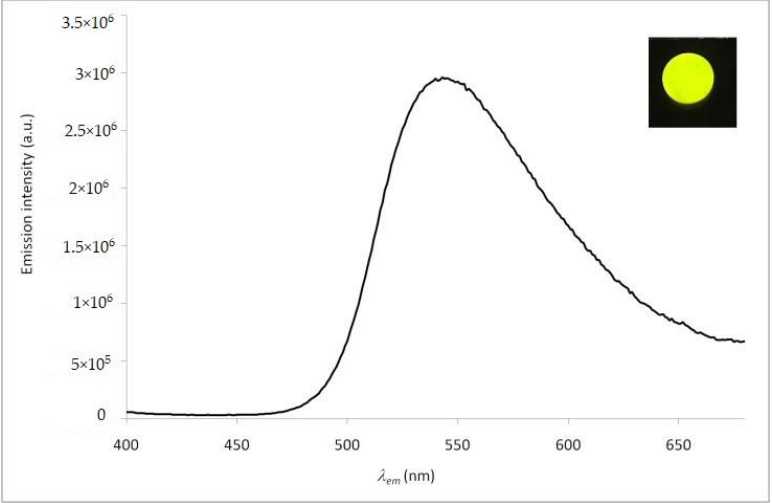
Figure 4. Solid state emission spectrum of compound 1 in KBr pellet (3 wt% of 1 ) matrix. Inset: picture taken in the dark of the KBr pellet upon irradiation with a handheld UV lamp ( λ em = 366